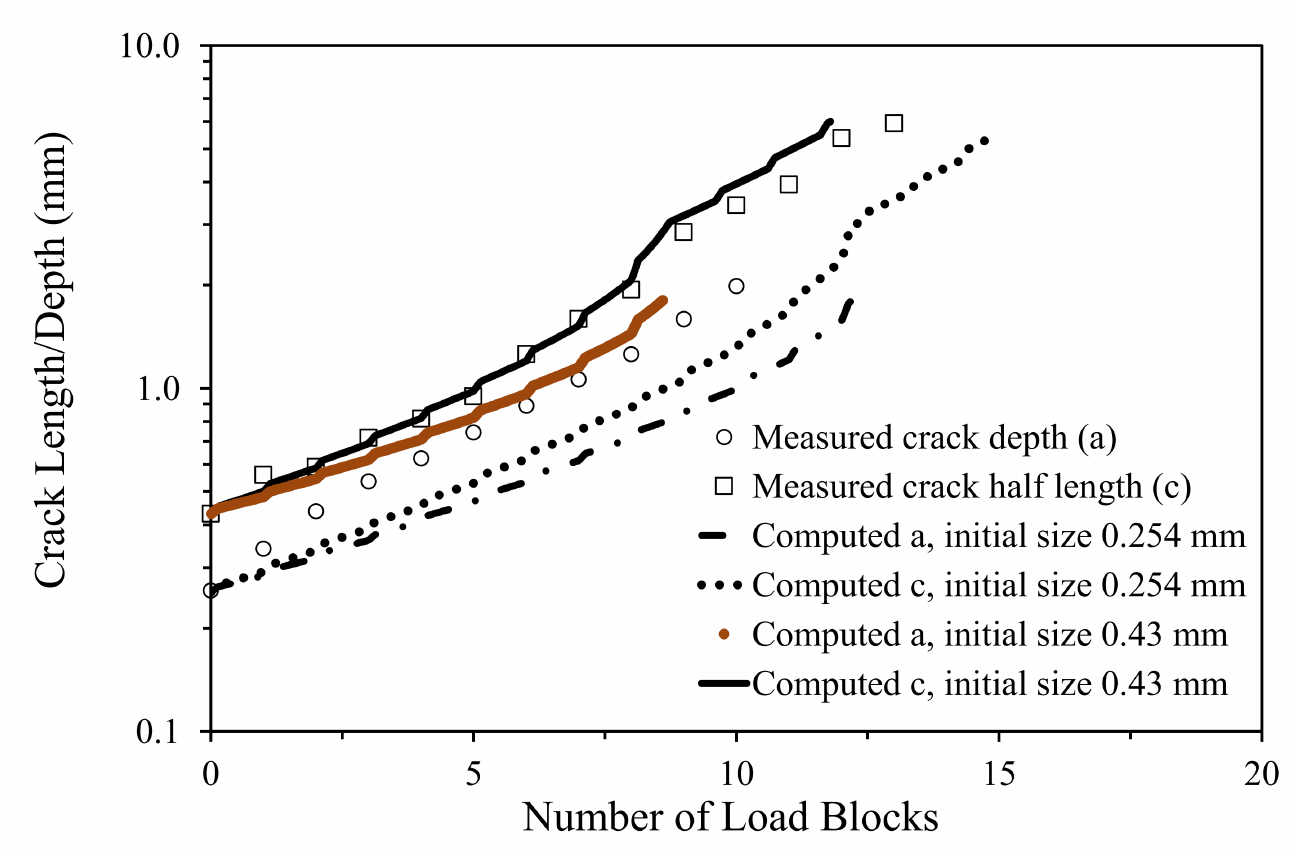
Figure 10. Comparison between measured and computed crack growth histories, assuming and EIDS with c / a =